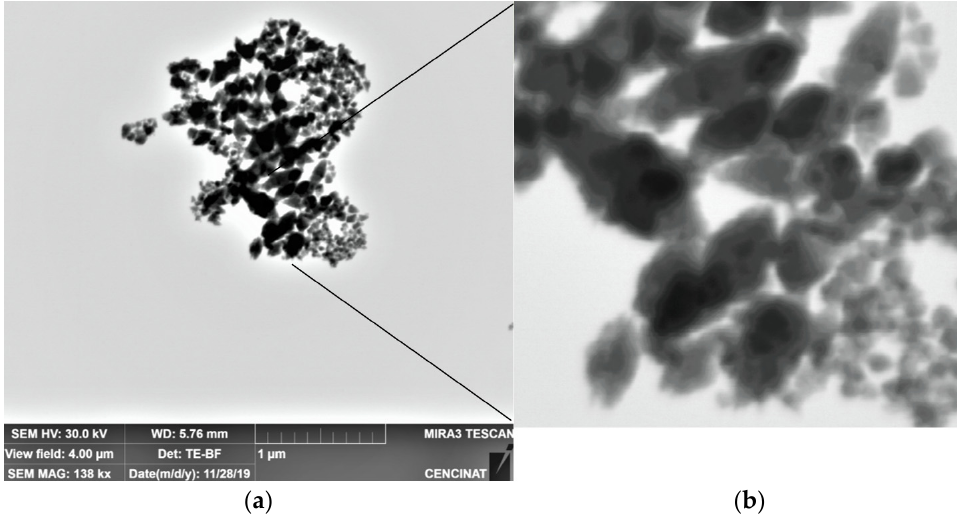
Figure 7. ( a ) SEM; nanoparticles of ZnO 0.1 mol/L, with view field 4.00 µm; ( b ) zoomed image.